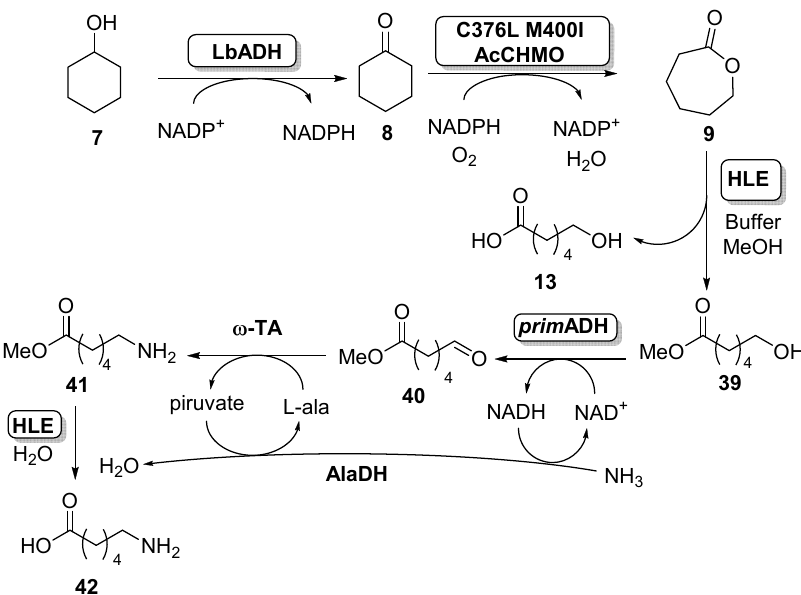
Scheme 16. Multienzymatic system for the preparation of 6-aminohexanoic acid ( 42